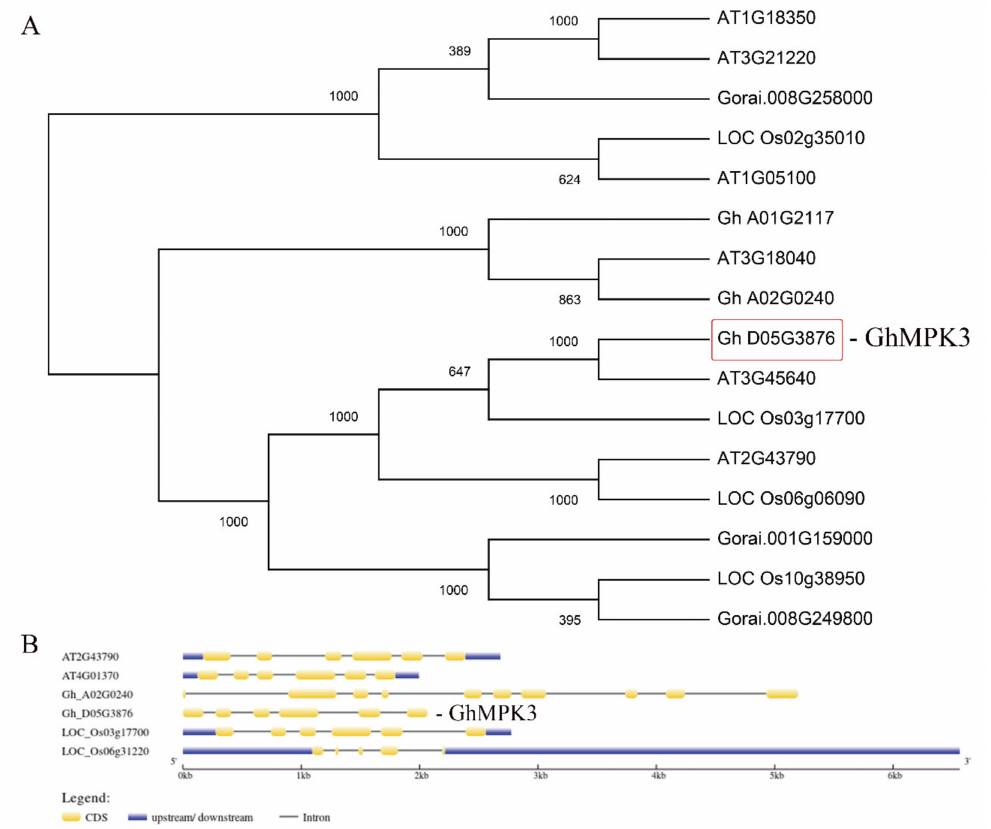
Figure 1. Comparison of the amino acid sequences of GhMPK3 and closely related plant mitogen- activated protein kinase. ( A ) The phylogenetic relationships between GhMPK3 and MAPK proteins in other plants. MEGA 7 was used for the development of the phylogenetic tree using the CLUSTALW by neighbor-joining (NJ) method. Bootstrap values of 1000 replicates are shown in each branch. Protein ID represents the gene names: Arabidopsis thaliana –AT , Gossypium hirsutum— Gh Oryza sativa—LOC , and Gossypium raimondii—Gorai ( B ) GhMPK3 ( Gh_D03G1517) genomic DNA structure comparison with other MAPK from other plants. The pattern of exons, introns, and untranslated regions is dis- played in the legend (UTRs). The length of the sequence is indicated by the X-axis scale. The following are the abbreviations for the species names: At for Arabidopsis thaliana , Gh for Gossypium hirsutum , and Loc for Oryza